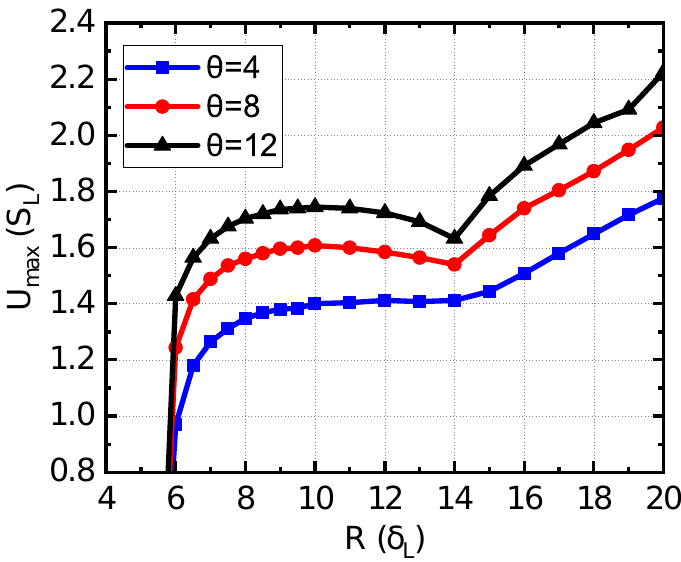
Figure 5. Centerline velocity U max , c versus channel half-width R at the critical condition. θ = 4,8,12. In Figure 6, the flame shape at the critical condition is represented by the normalized reaction rate and temperature isolines for different channel widths. Streamlines are plotted in white. For the smallest channel half-width R = 6.5 δ L , the flame is convex at the centerline, and the streamlines are deflected from the centerline towards the walls. For the channel half-width R = 12 δ L the flame front at the centerline is flat; thus, the flame “tip” is still at the centerline, so qualitatively, it is similar to that of R = 6.5 δ L . For R = 20 δ L , the leading point shifts to the vicinity of the wall, where the flame propagation is able to balance the lower velocity. It can be seen that the streamlines are affected by the flame only within a limited distance ahead of the flame tip at the critical condition.